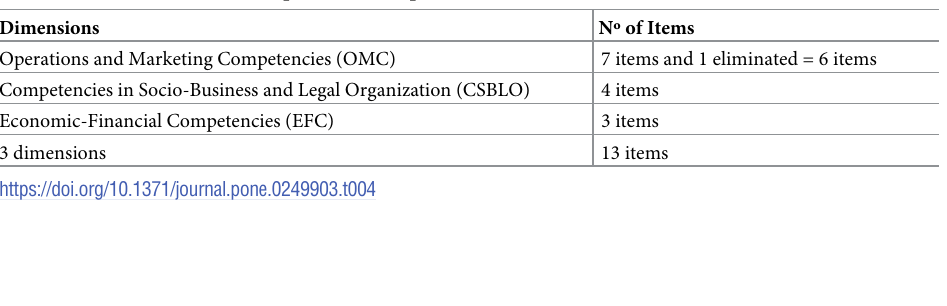
scores > .45, showing a good degree of homogeneity(Table 3).